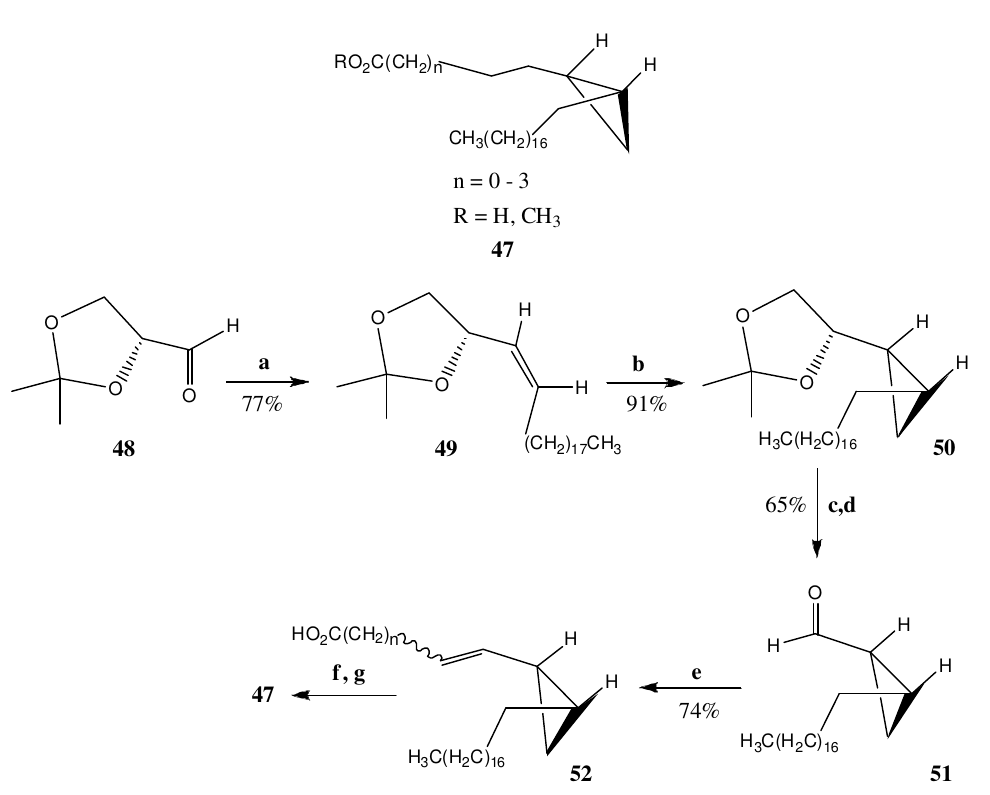
SCHEME 11. Synthesis of mycolic acid analogues 47 proposed by Minnikin and coworkers. (a) Br – Ph 3 P + (CH 2 ) 18 Me, n -BuLi THF,–78°C; (b) Et 2 Zn ClCH 2 I, 1,2-dichloroethane -30°C; (c) HCl, MeOH; (d) NaIO 4 , H 2 O; (e)